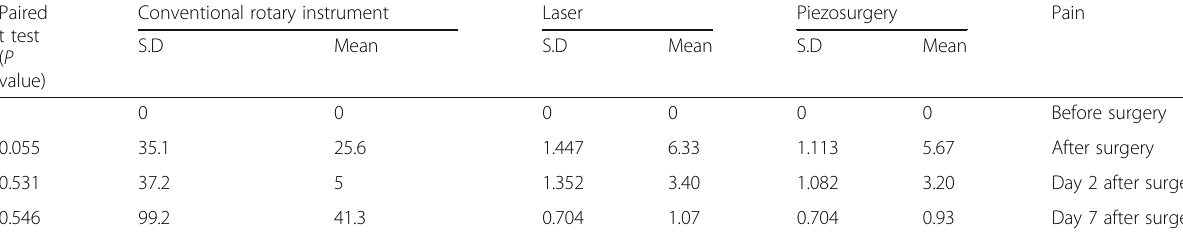
Table 1 Comparison of pain variable in the three surgical techniques Paired t test